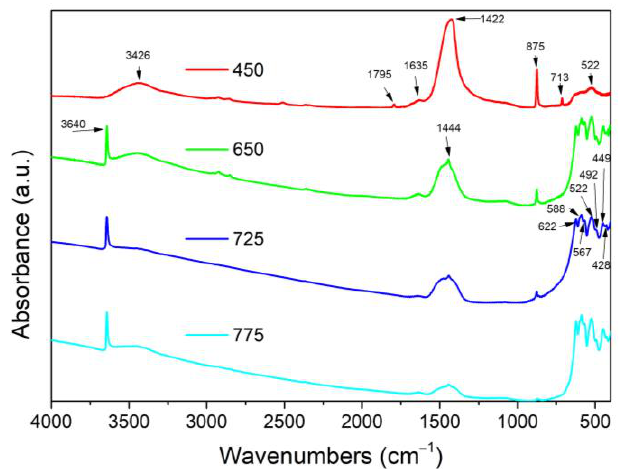
Figure 2. FTIR spectra of CBO samples calcinated at different temperatures.